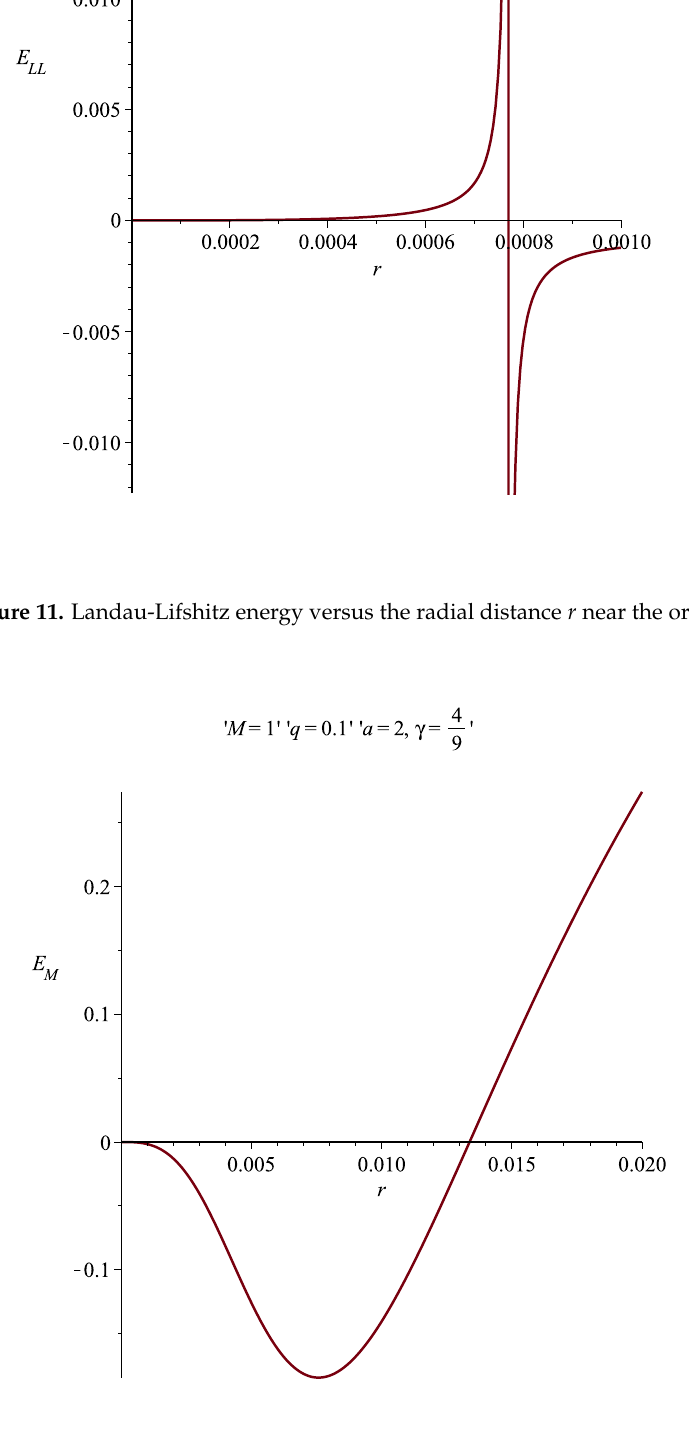
Figure 12. Møller energy versus the radial distance r near the